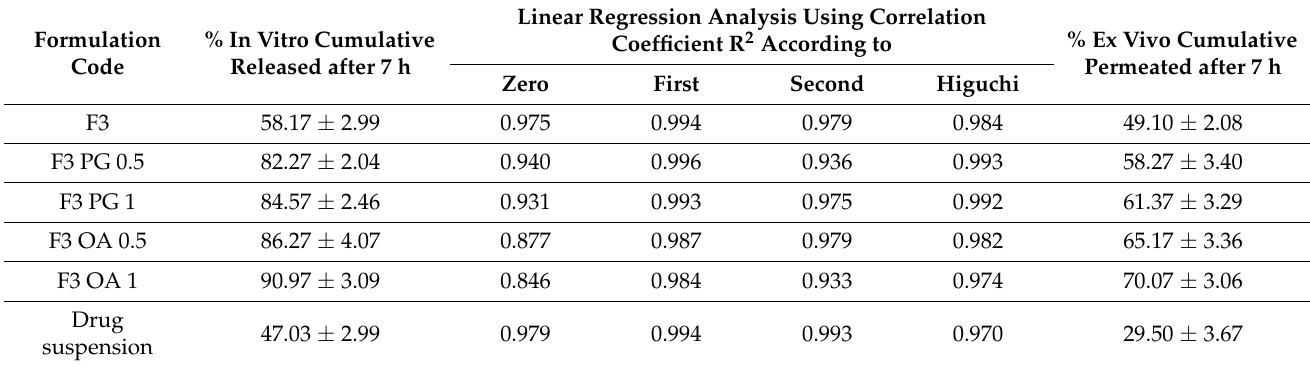
Table 3. In vitro release, the kinetic parameters and ex vivo permeation of different permeation enhancers containing TCR–SPLs ( n = 3, mean ±